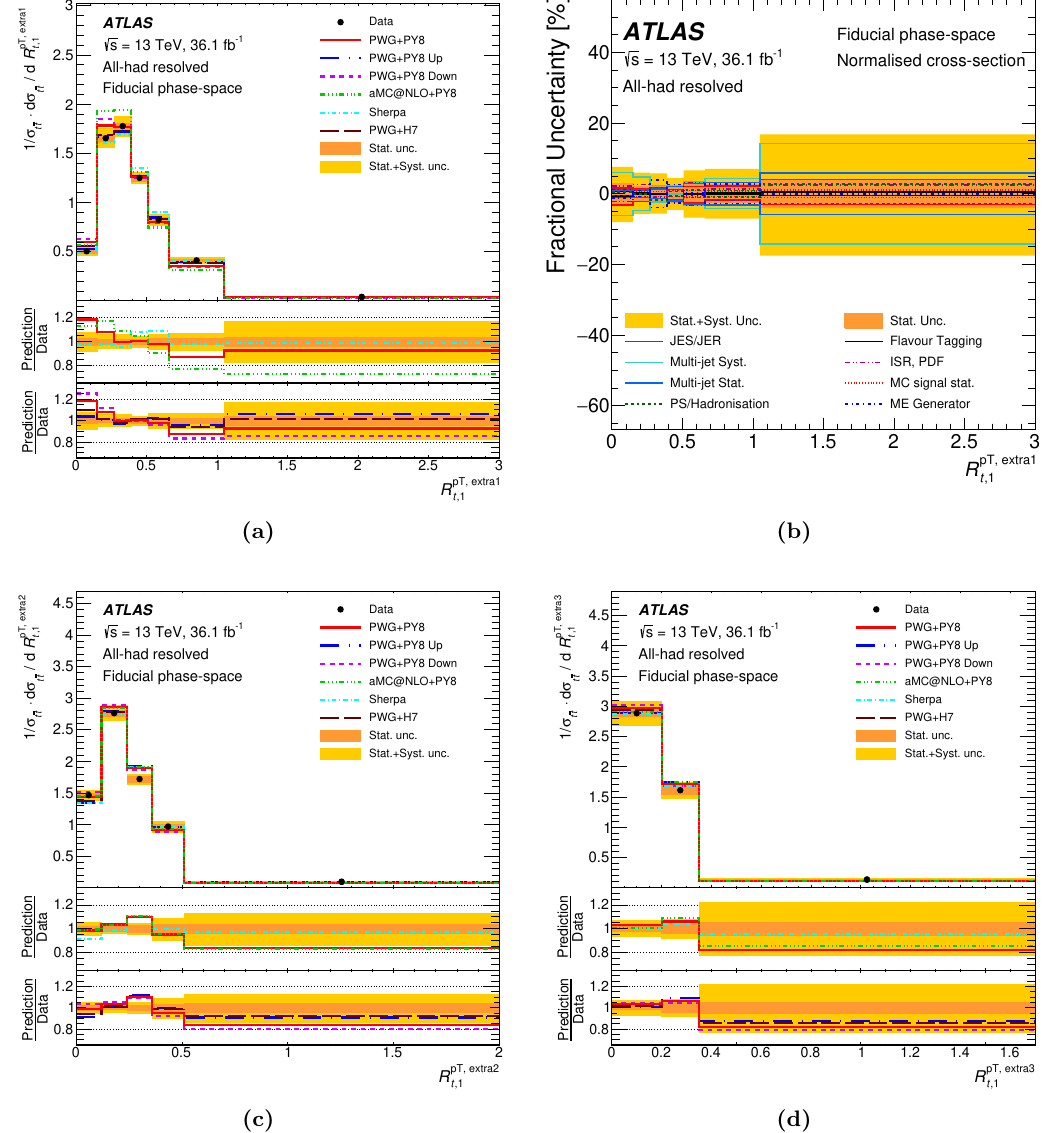
Figure 12 . Particle-level single-differential normalised cross-sections (a, c, d) as a function of the ratio of the leading (a), sub-leading (c) and sub-subleading (d) extra jet p to the leading top- T quark p . In the top panel, the unfolded data are shown as black points, while lines indicate the T predictions from several MC programs. Uncertainties are shown by the shaded bands. Data points are placed at the centre of each bin. The lower two panels show the ratio of the MC predictions to the unfolded data. Fractional uncertainties (b) for the normalised single-differential cross-sections as a function of the ratio of leading extra jet p to the leading top-quark p . The bands represent T T the uncertainties in the unfolded data. Lines indicate the breakdown of the major components of the